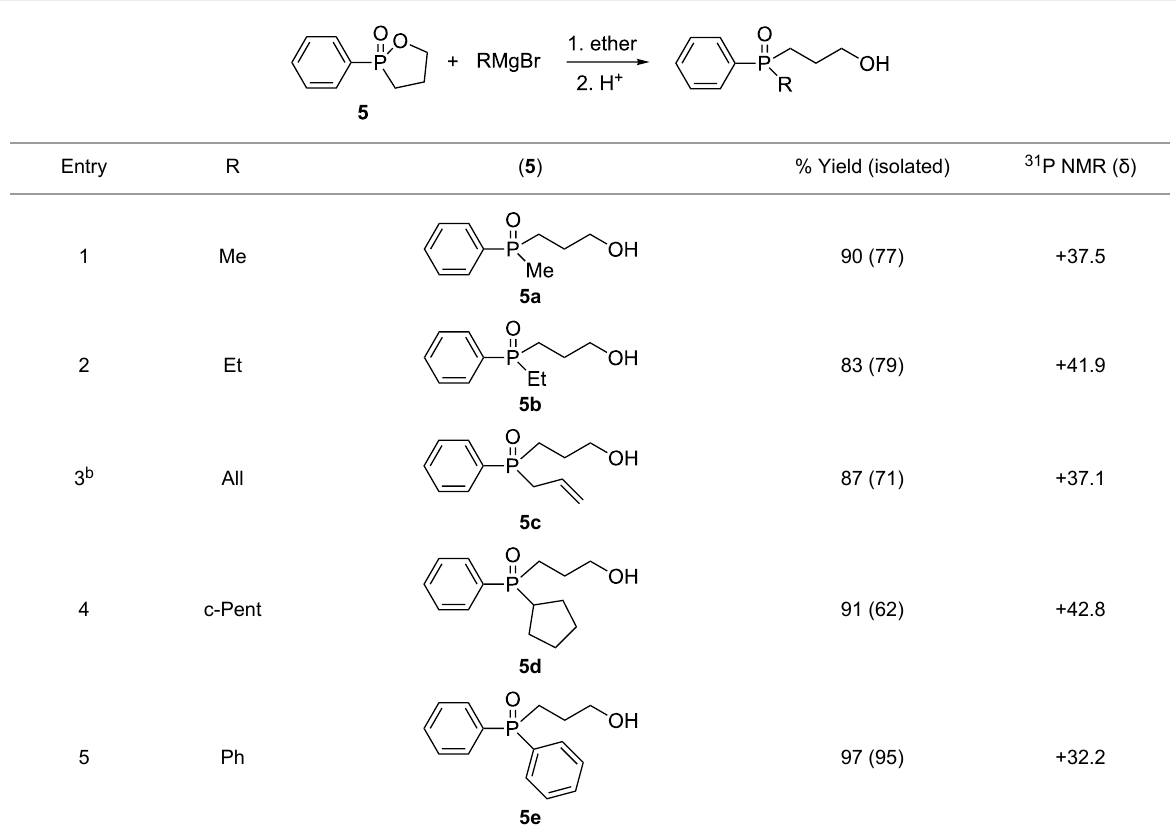
Table 2: Synthesis of γ -hydroxypropyl (±)-phosphine oxides a